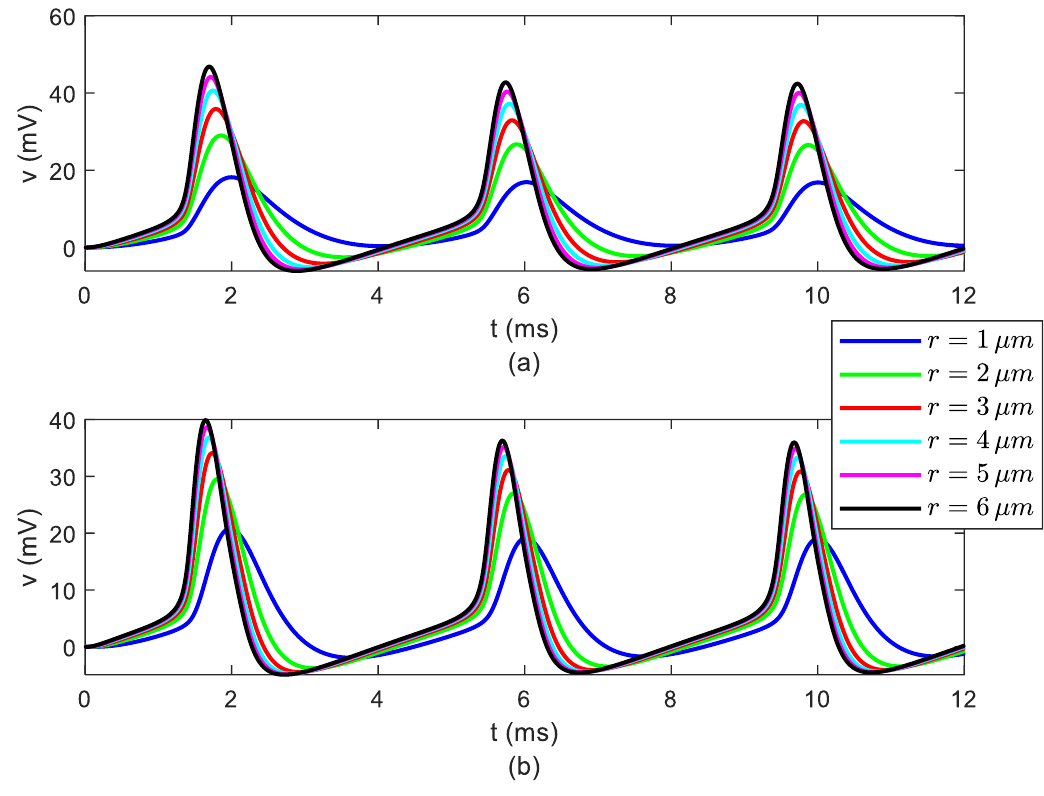
Figure 9. Profiles of 𝒗(𝒙, 𝒕) for (a) 𝜶 = 𝟎. 𝟔𝟓 and (b) 𝜶 = 𝟏 at 𝒙 = 𝟕𝟎𝟎 𝝁𝒎 for various values of the axon’s radius 𝒓 .